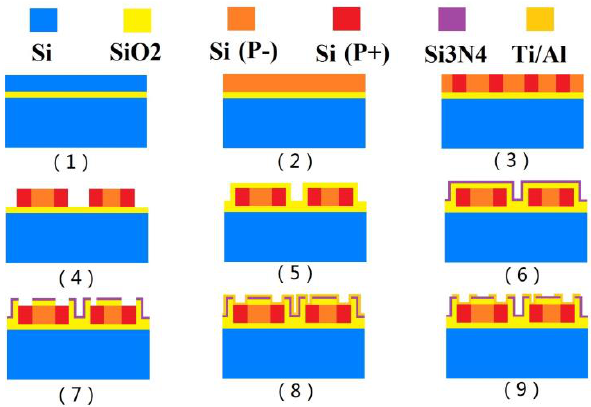
Figure 6. Fabrication process of MEMS strain gauge.